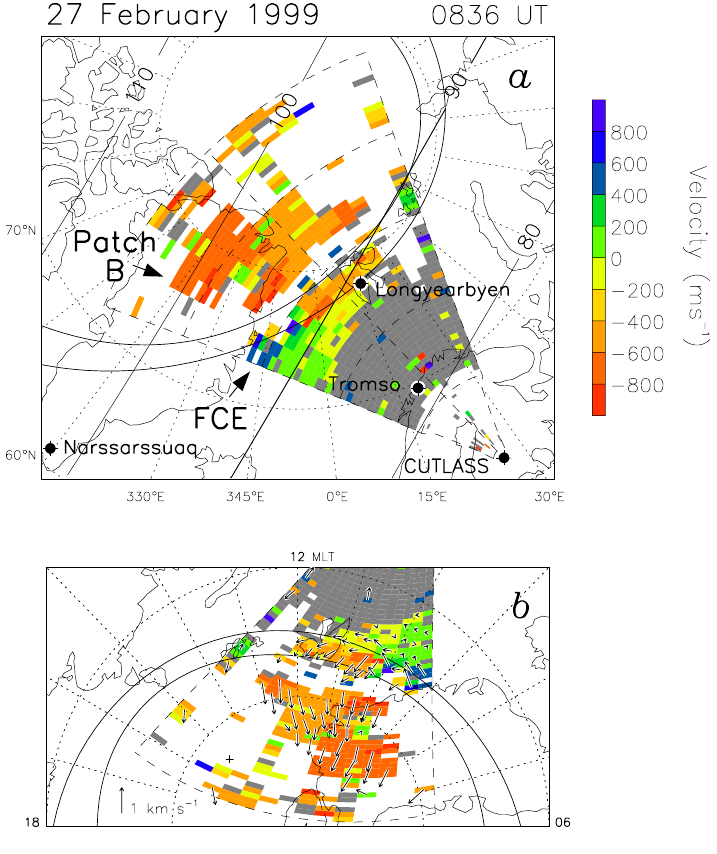
Fig. 1. The location of the field-of- view of the CUTLASS Finland radar system. Also indicated are the lo- cations of the Longyearbyen, Tromsø, and Narssarssuaq vertical ionosondes employed in the study. Line-of-sight plasma drift velocities from the radar scan starting 08:36UT, on 27 February 1999, are presented. The statistical oval and solar zenith angles for this time are superimposed. The lower panel shows the same radar scan presented in a mag- netic latitude and magnetic local time format. Beam-swung vectors are super-